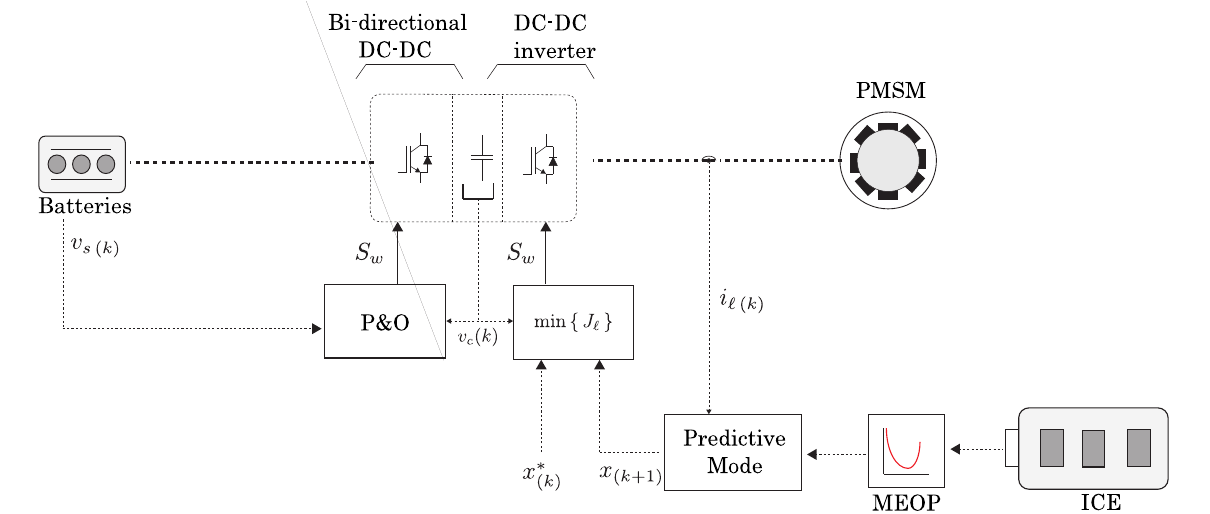
Figure 9. Overall optimization strategy and control